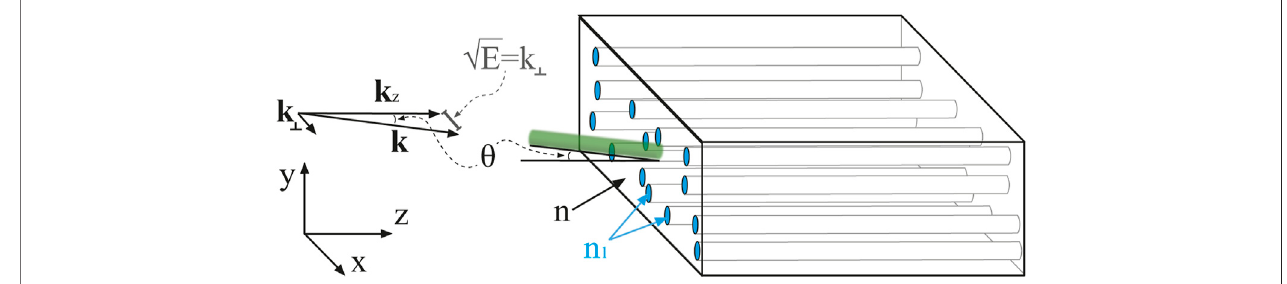
FIGURE1| Sketchoftransverselocalization:sketchofthescatteringstructureandilluminationfortherealizationoftheTL.Light,intheformofaplanewavede fi ned by the wavevector k , is impinging on the sample, with an azimuthal angle θ . The projection of the wavevector on the x - y plane (parallel to the fi ber facet) k ⊥ and the projection of the wavevector on the propagation direction z ( k z ) are reported, together with the spectral parameter typicallyconsistingofamatrixofrefractiveindex n containing “ inclusions ” withadifferentrefractiveindex n 1 .Toworkas “ paraxialdefects ” ,thedefectstructureswith index n 1 should be precisely parallel to z